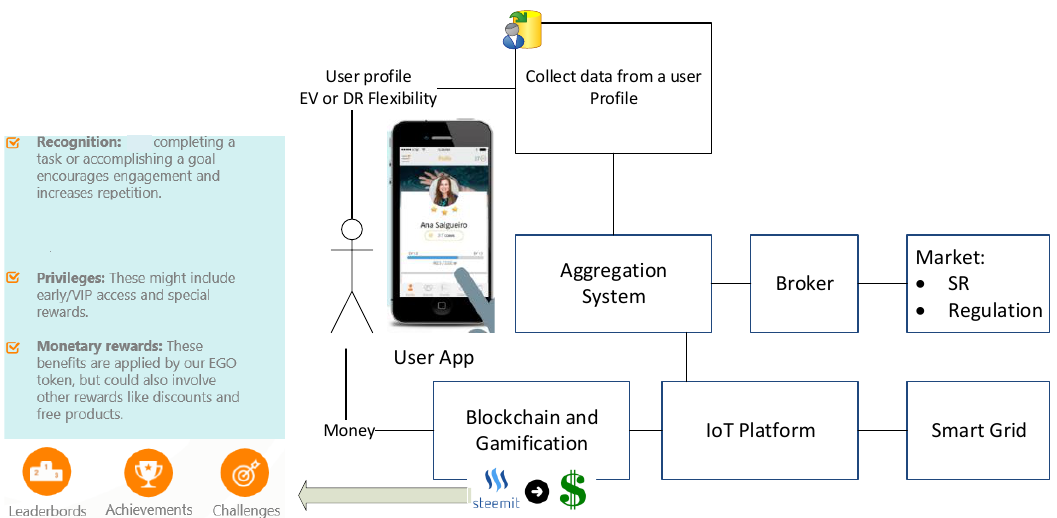
Figure 8. Gamification approach implemented towards EV spinning reserve market participation, as well as DR flexibility.